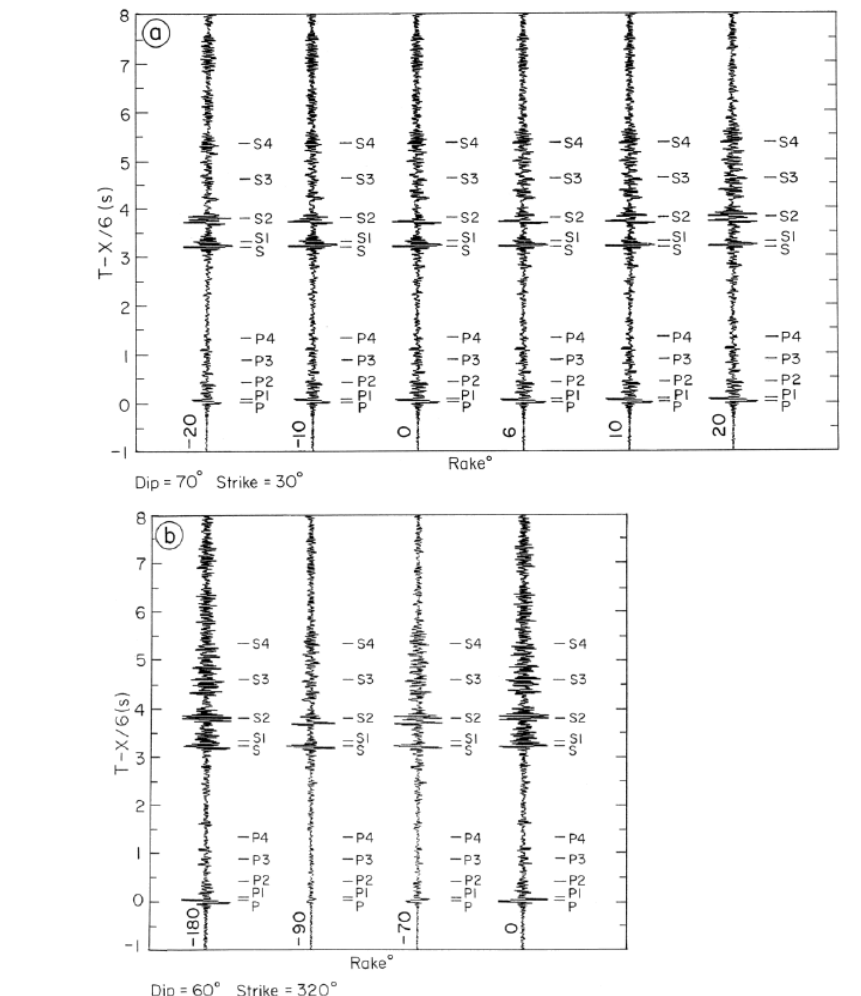
Figure 3. (a) Vertical-component reflectivity seismograms gather (true amplitudes plot with reduction velocity 6 km/sec) for a common off- set range of 28 km showing amplitude variations of different phases due to rake angle variations of various source mechanisms. All the seis- mograms are computed for the source depth of 6 km using the P and S velocity models shown in Figure 2. Onsets of various travel-time branches are given to the right of the seismograms. Note the P phase amplitudes are however recognizable for rake angles in the range of at least −20° to +20°. (b) Same as Figure 3a for the normal faulting mechanism. Note very low amplitude P phases for the intermediate rake angles near −90°.